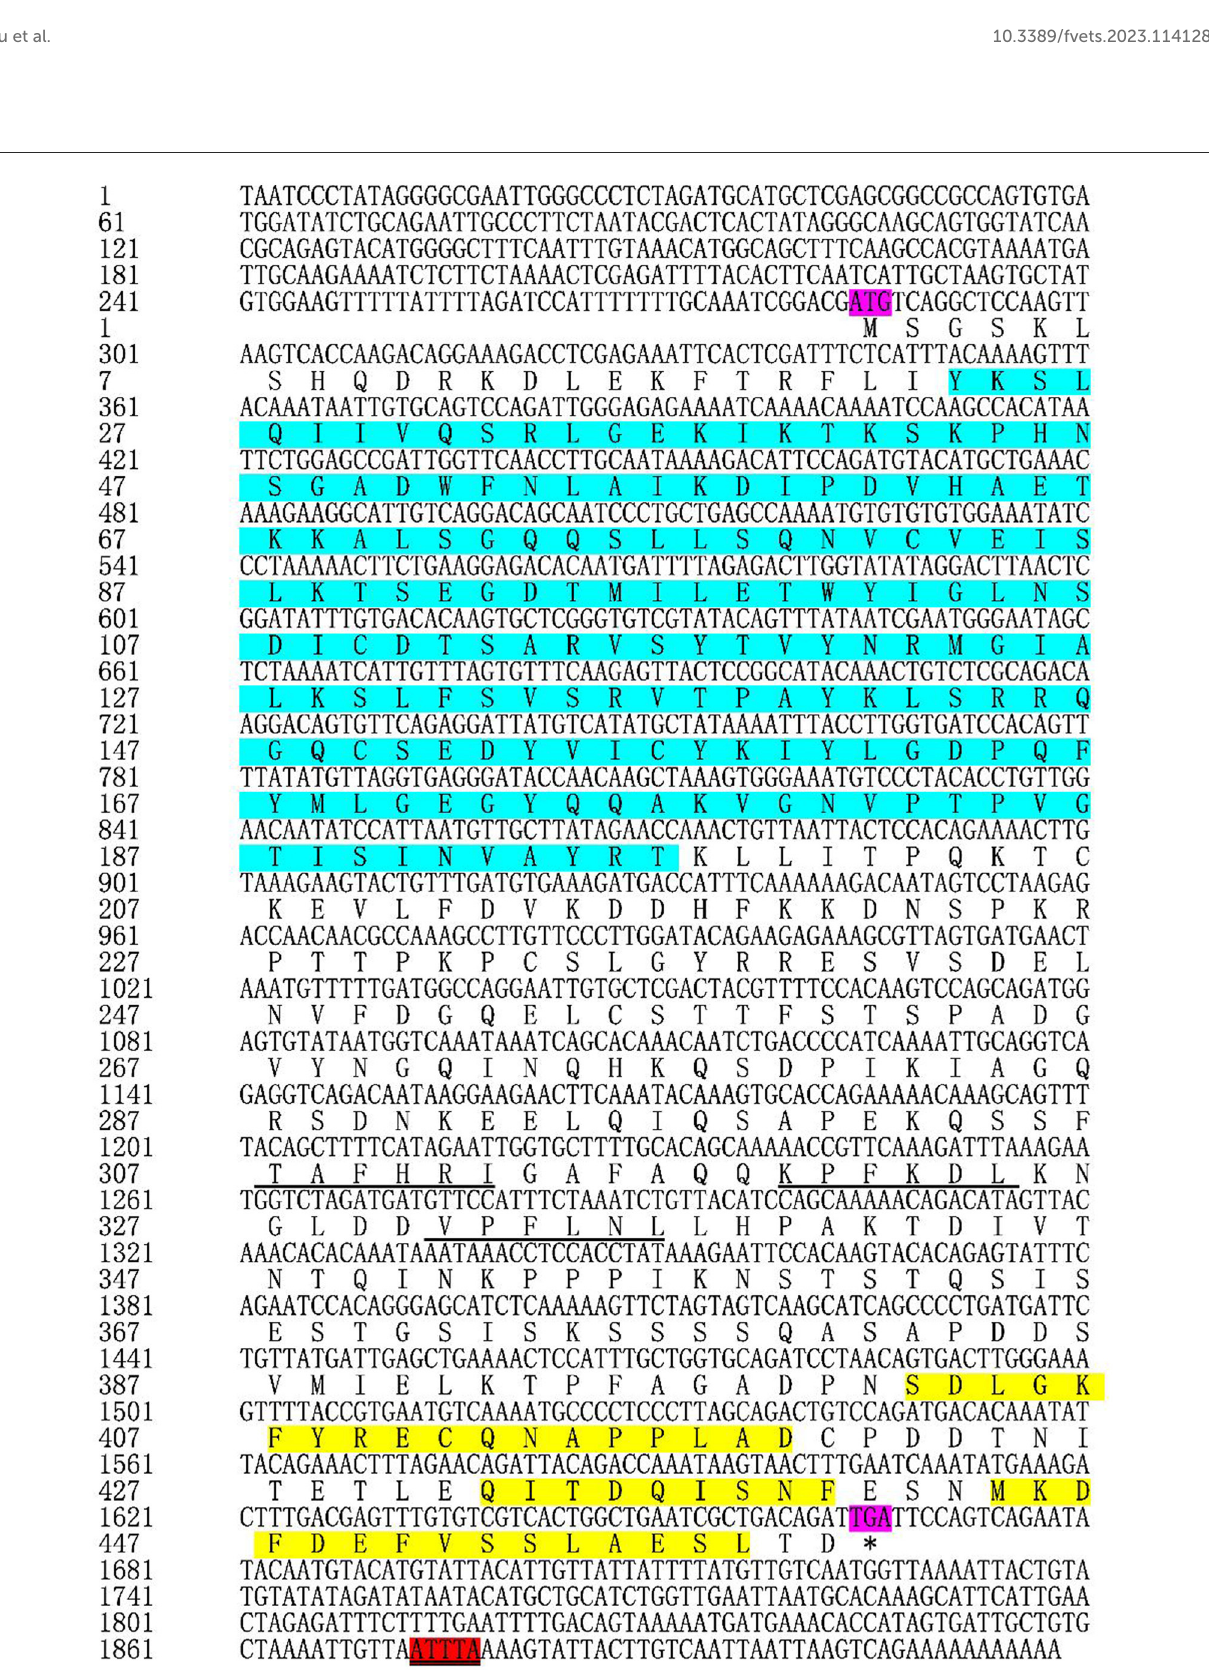
FIGURE1 Nucleotide and deduced amino acid sequences of TgATG13. The start codon (ATG) and stop codon (TGA) are labeled purple. The amino acids (23–196) that form the conserved HORMA domain are labeled blue. The typical ATTTA motif was marked red. The action domains of LC3 are marked by underline and the corresponding three tubulin motifs are labeled yellow. * represents the stop